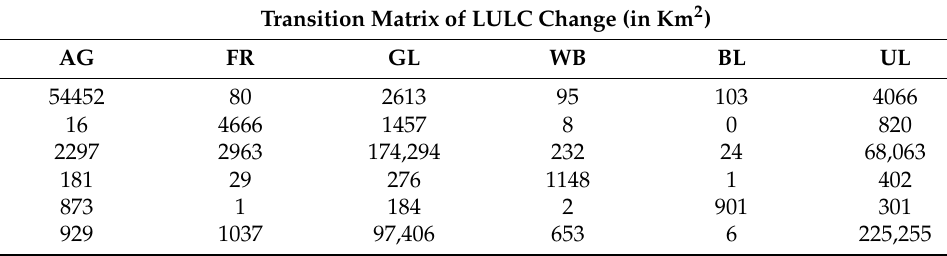
Table 7. Direction of LULC